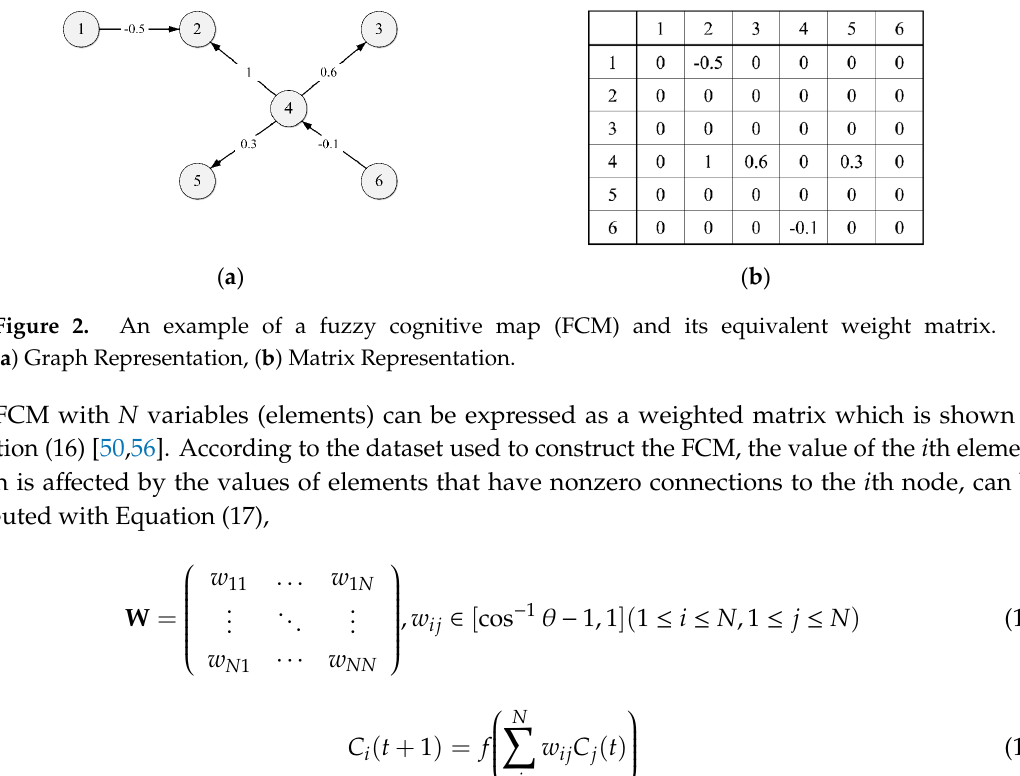
Figure 3. The function diagram of f ( x ) with di ff erent λ 0 ; ( a ) λ 0 = 1, 2, 3, 4, 5, 6, 8, 10, ( b ) λ 0 = 10, 20, 30, 40, 50, 60, 80, 100.